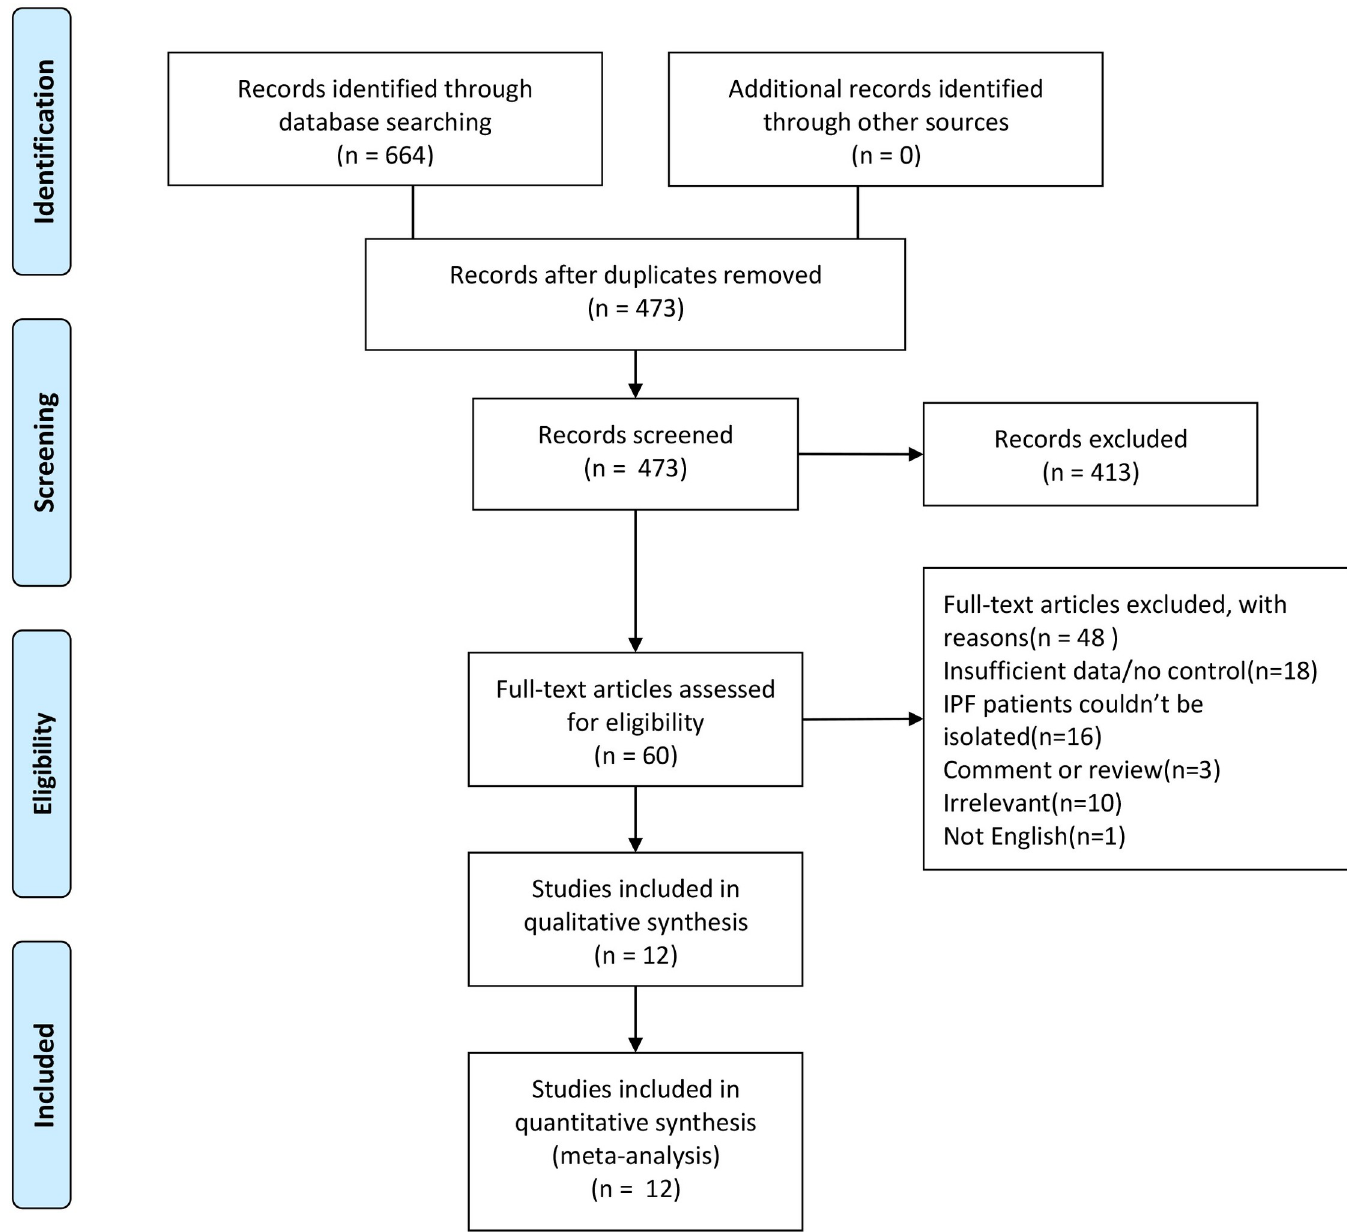
Fig 1. PRISMA flow diagram of the literature search in this meta-analysis.